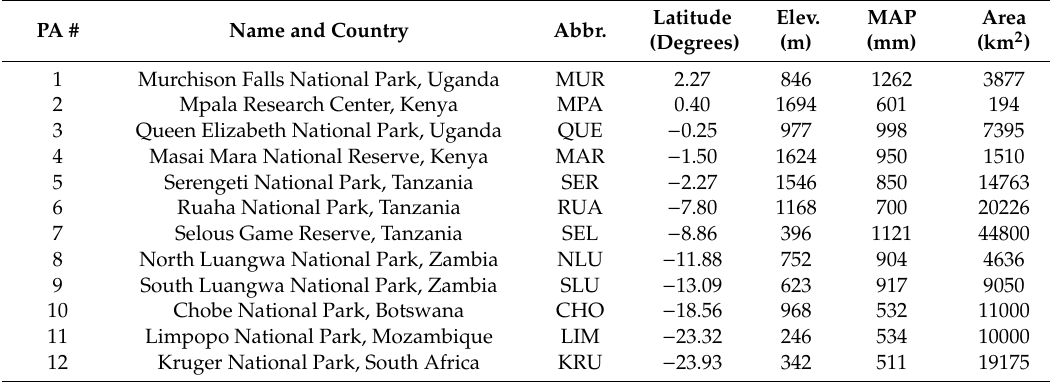
Table 1. Protected area names, abbreviations and attributes, listed from north to south. PA numbering corresponds to Figure 1.